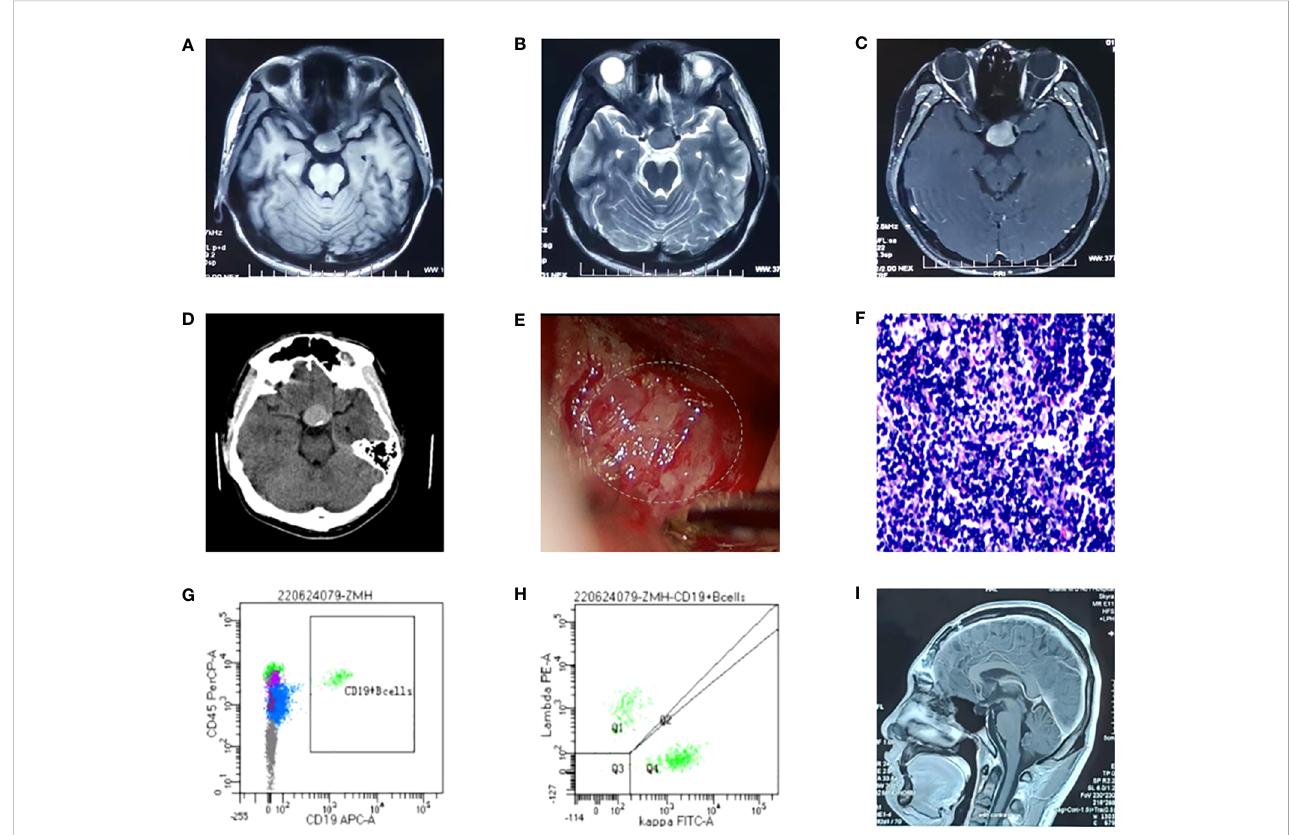
FIGURE 1 (A-C) Head MRI: the sella was expanded, with an oval slightly long T1 and long T2 abnormal signal, and there was uneven enhancement and a clear boundary. The neurohypophysis is clearly shown, the left optic chiasm is compressed, and the internal carotid artery in the left cavernous sinus is partially surrounded. The intracranial segment of the left optic nerve were compressed and slightly thinned, and the enhanced scan showed mild enhancement; (D) Head CT: the sella is enlarged, high-density nodules are seen in the pituitary fossa, the size is about 2.1*2.8cm, and the CT value is about 56HU; (E) The tumor was found to have abundant blood supply during the operation; (F) Pathological section: Proliferating tumor cells and have a starry sky appearance and they are dense, with medium cell volume, thin cytoplasm, large and slightly irregular nuclei, and fi ne chromatin; (G, H) Flow cytometry, and we found that B lymphocytes with CD19+CD20+ accounted for about 19.8% of lymphocytes, with polyclonal expression of Kappa and Lambda; (I) Postoperative re-examination of head MRI showed no tumor